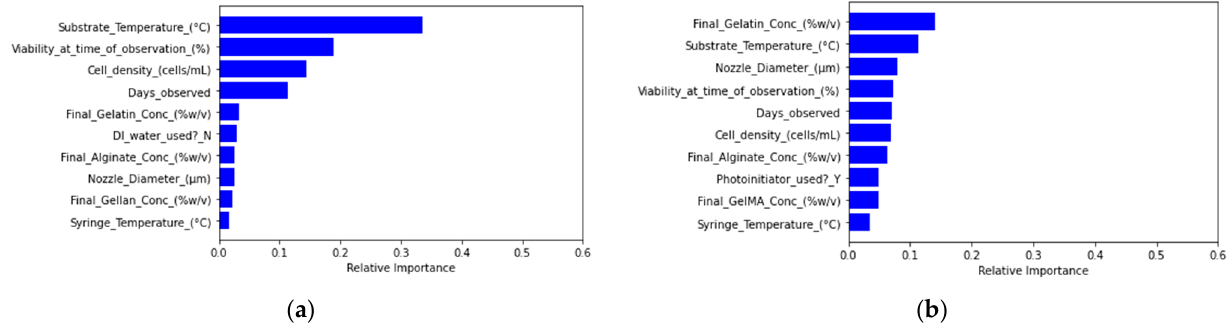
Figure 10. Feature importance rankings of material, equipment, and experimental parameters based on ( a ) random forest regression modeling of extrusion pressure and ( b ) random forest classification modeling.